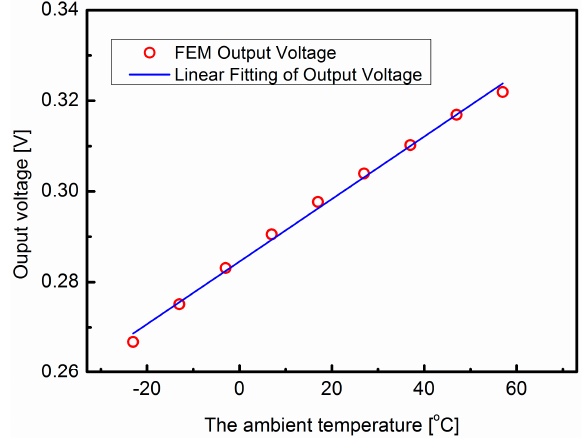
Figure 6. Simulation results of the effect of the silicon and ceramic substrates on the output voltage at different temperatures. The output voltage curve is a linear function of the ambient temperature.